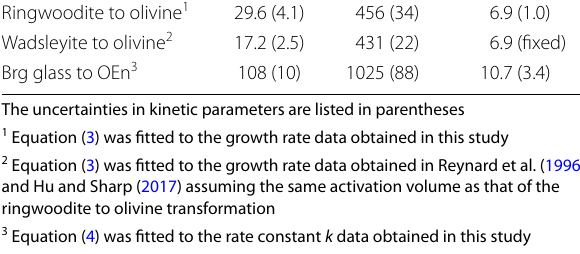
Table 3 P and T dependences of the rate constant k and growth rate